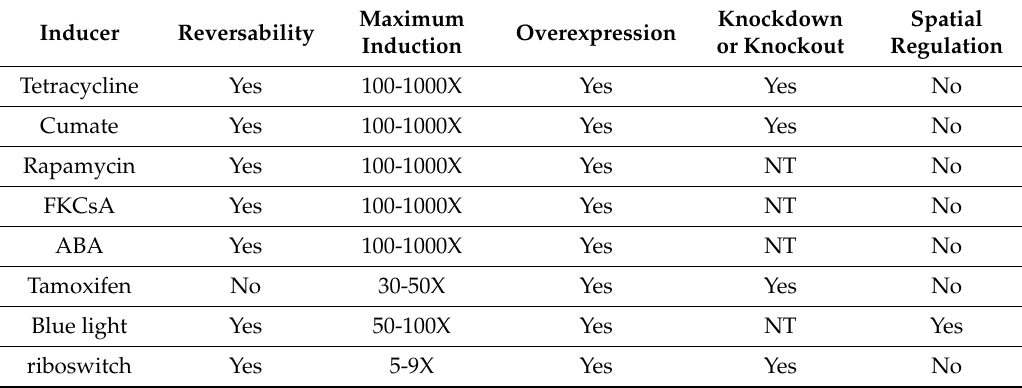
Table 2. Brief comparison of reviewed induction systems (listed according to